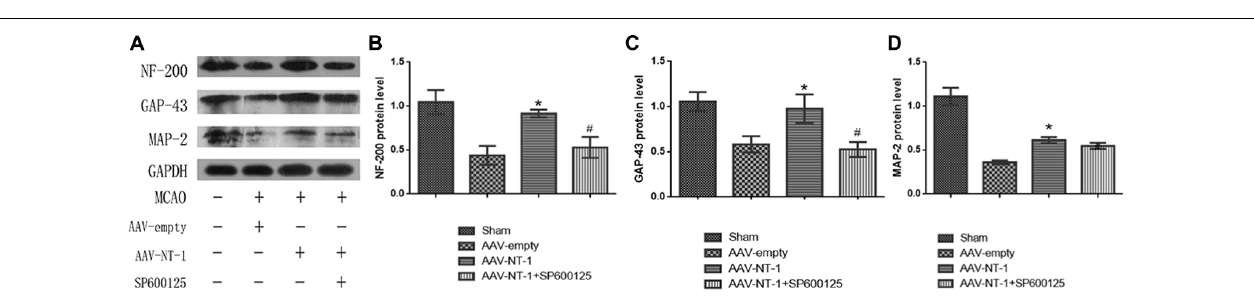
FIGURE 7 | Effects of Netrin-1 overexpression and/or JNK inhibition on the neural ultra-structural modification after the MCAO. Representative images of each group were shown. Rats in each group were sacrificed at Day 14 after the MCAO. (A) Sham group. (B) AAV-empty group. (C) AAV-NT-1 group. (D) AAV-NT-1+SP600125 group. Red arrows point at the post-synaptic area. Scale bars = 400 nm. (E) Analysis of PSD thickness ( n = 30), ∗ p < 0.001, as compared with AAV-empty group, # p < 0.01, as compared with the AAV-empty group. (F) analysis of PSD area (n = 30), ∗ p < 0.01, as compared with AAV-empty group, # p < 0.05, as compared with AAV-empty group. (G) analysis of synaptic cleft width ( n = 30), ∗ p < 0.001, as compared with AAV-empty group, # p < 0.01, as compared with AAV-empty group. (H) analysis of PSD length ( n = 30), no significant difference in PSD length among the groups. (I) analysis of PSD length ( n = 30), no significant difference in the curvature of synaptic interface among the groups.